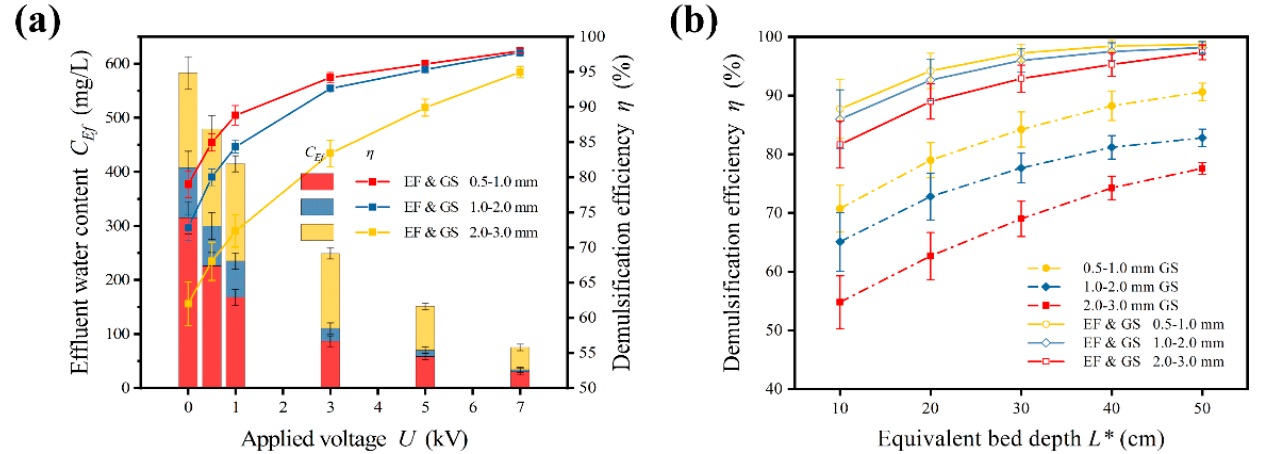
Figure 9. Effects of medium bed parameters ( a ) Effect of medium particle size. ( b ) Effect of bed depth. Conditions: C in = 1500 mg/L; v = 0.001 m/s; U = 0–7 kV; GS medium bed with size of 0.5–1.0 mm, 1.0–2.0 mm and 2.0–3.0 mm and L* = 20cm.